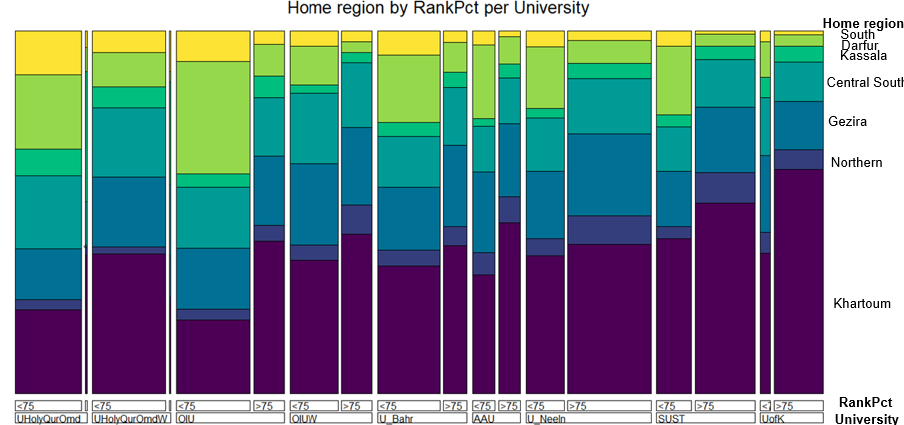
Figure 21. Comparison of geographic diversity of lower-ranking students (below 75th percentile) versus higher ranking students (above 75th percentile) that entered bachelor’s programs in (2016–2017), for selected universities in Khartoum (double-decker